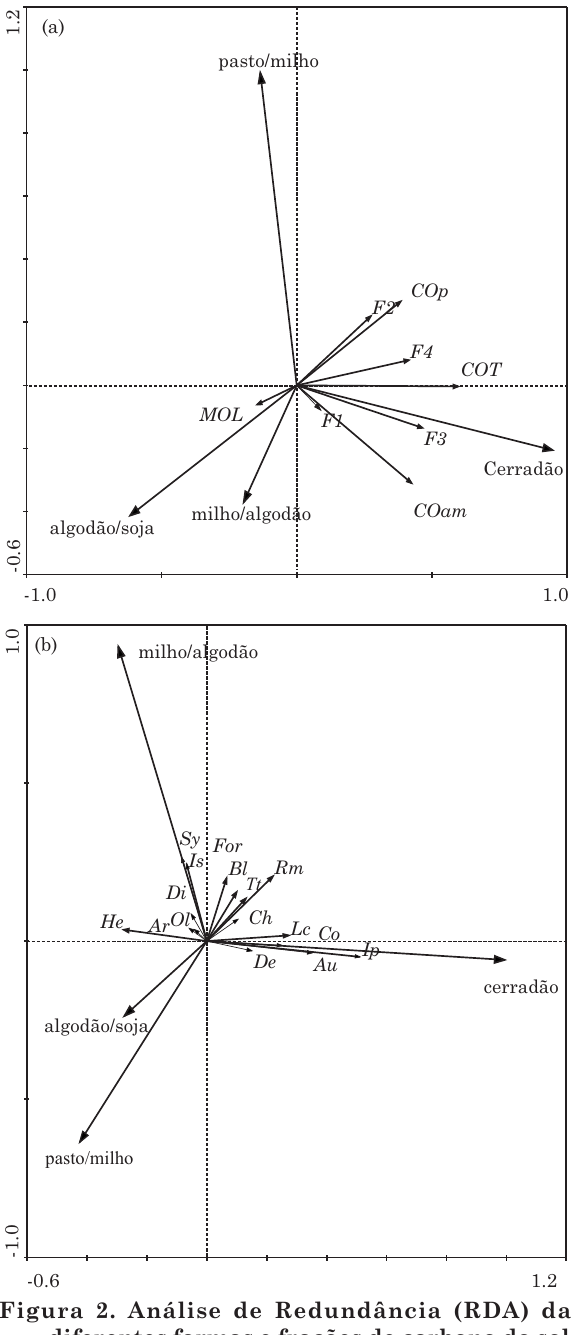
-0.6 1.2 Figura 2. Análise de Redundância (RDA) das diferentes formas e frações de carbono do solo (a) e da macrofauna do solo em função de áreas avaliadas (b). COT: carbono orgânico total, COp: carbono orgânico particulado, COam: carbono orgânico associado aos minerais, MOL: matéria orgânica leve em água, F1, F2, F3 e F4: frações oxidáveis da matéria orgânica, Ar: Araneae, Au: Auchenorrhyncha, Bl: Blattodea, Ch: Chilopoda, Co: Coleoptera, De: Dermaptera, Di: Diplopoda, For: Formicidae, He: Heteroptera, Is: Isopoda, Ip: Isoptera, Lc: Larvas de Coleoptera, Ol: Oligochaeta, Sy: Symphyla, Tt: Total e Rm: Riqueza